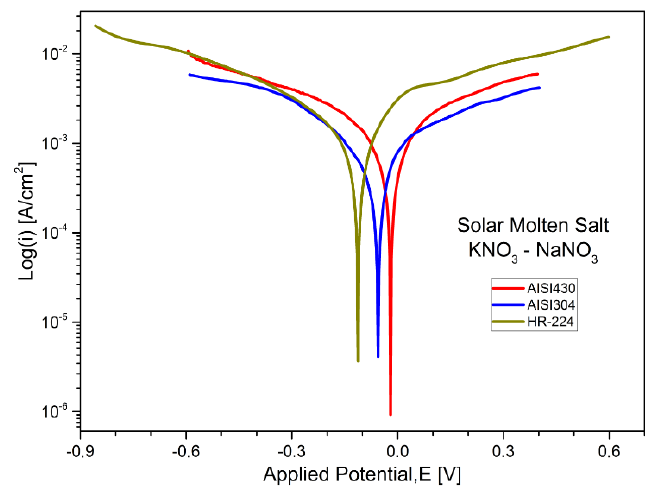
Figure 16. Polarization curves of stainless steel AISI 304, AISI 430, and nickel-based alloy HR-224 in KNaNO 3 (solar salt) at 550 °C and 100 h of exposure.